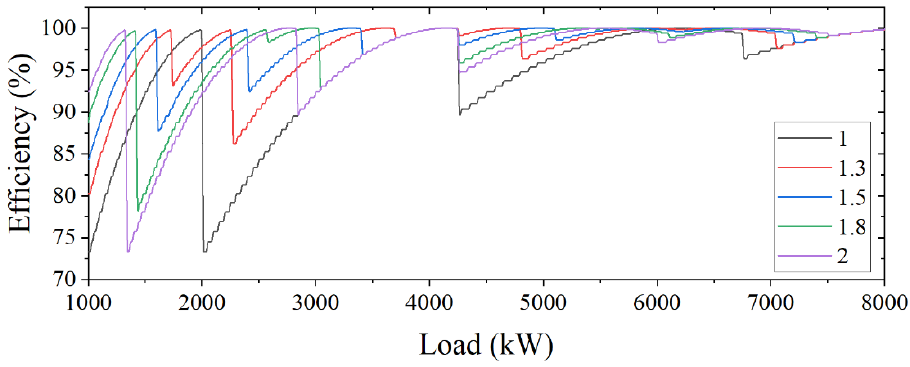
Figure 7. Efficiency change according to 𝐺𝐶𝐼 (cid:3029) value.